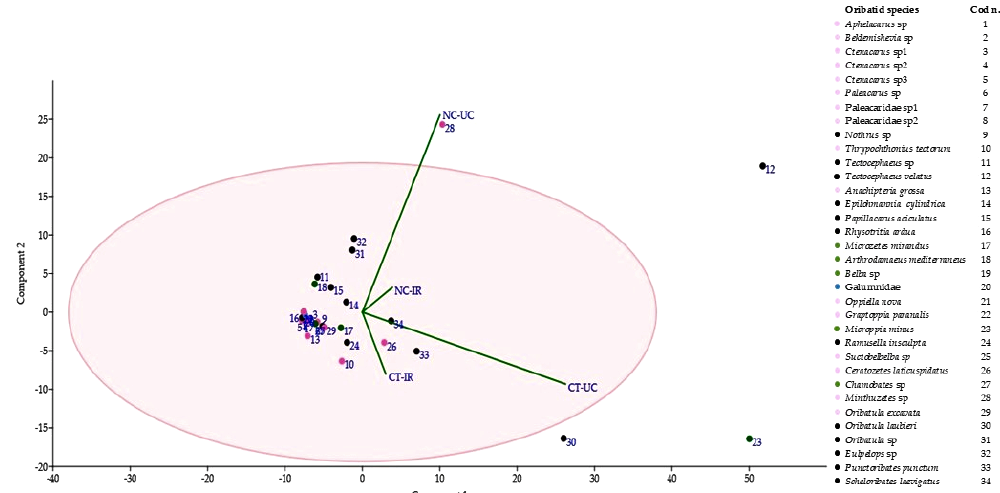
Figure 6. Biplot correlation of the oribatid assemblages in four soil management/position components (green loading values). The ellipse describes the variance at 95% and points to oribatid species with different colors based on their main feeding guilds: black: macrosaprophagous, light blue: polyphagous, pink: mycophagous and green: microsaprohagous.